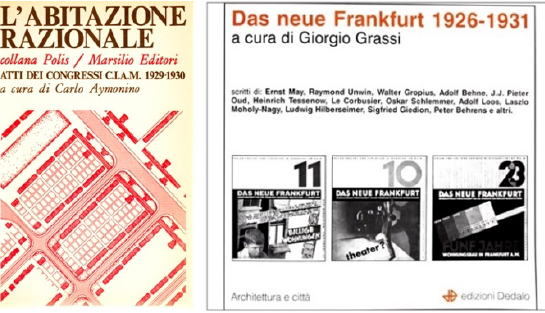
Figure 9. The definition of urban form: Frankfurt. From left to right: Carlo Aymonino, L’abitazione Razionale ( Ra- tional Dwelling ), 1971; Giorgio Grassi, Das neue Frankfurt 1926–1931 ( The New Frankfurt 1926–1931 ),